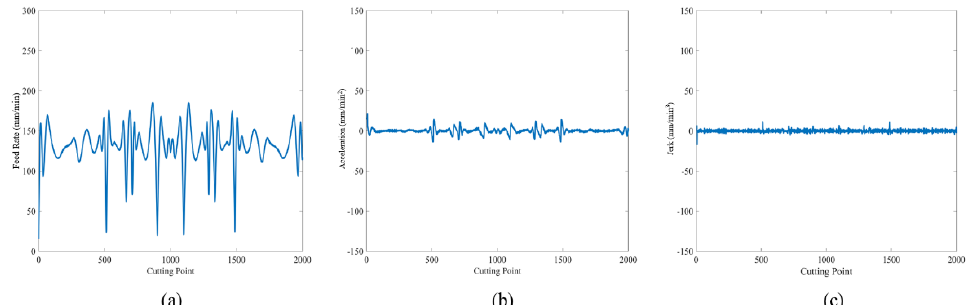
Figure 25. Cutting butterfly shape using method by Yeh and Hsu [10]: ( a ) feed rate, ( b ) acceleration, and ( c ) jerk.